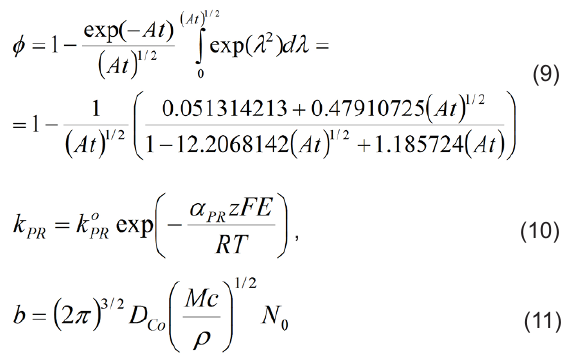
Figure 6. A set of current transients obtained from an aqueous solution 0.01M CoSO the potential step technique for different potential step values (mV) is shown. In all cases, the initial potential was 600